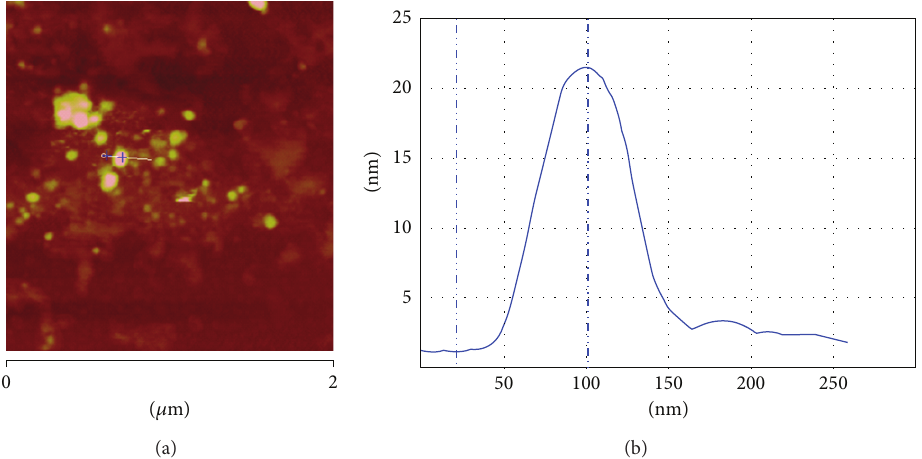
Figure 2: AFM of the glucan-Fe 3 O 4 nanoparticles: the height of the selected particle in (a) was shown in (b).